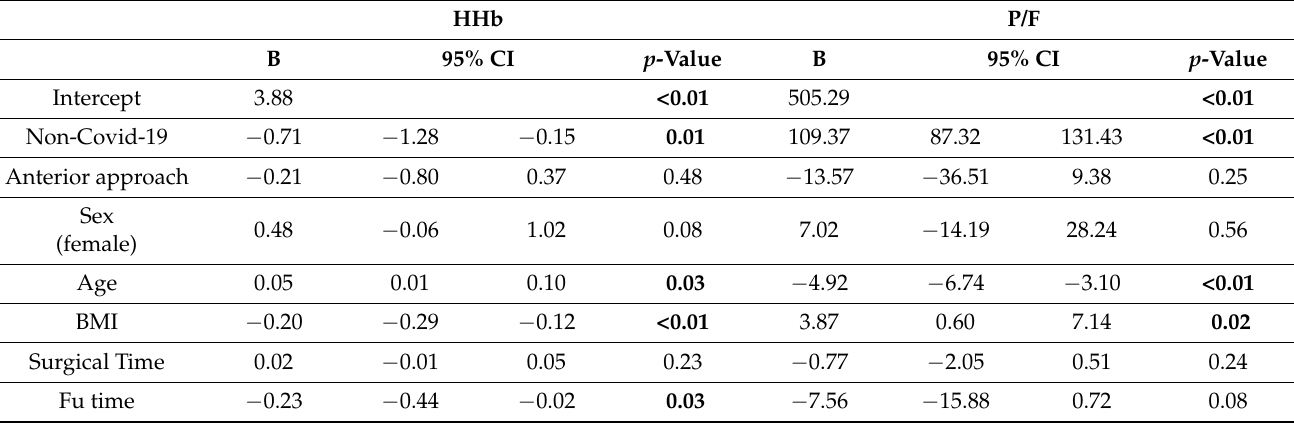
Table 9. Multiple linear regression models for respiratory values (HHb: hemoglobin subunit beta; Fu: follow up; BMI: Body Mass Index).